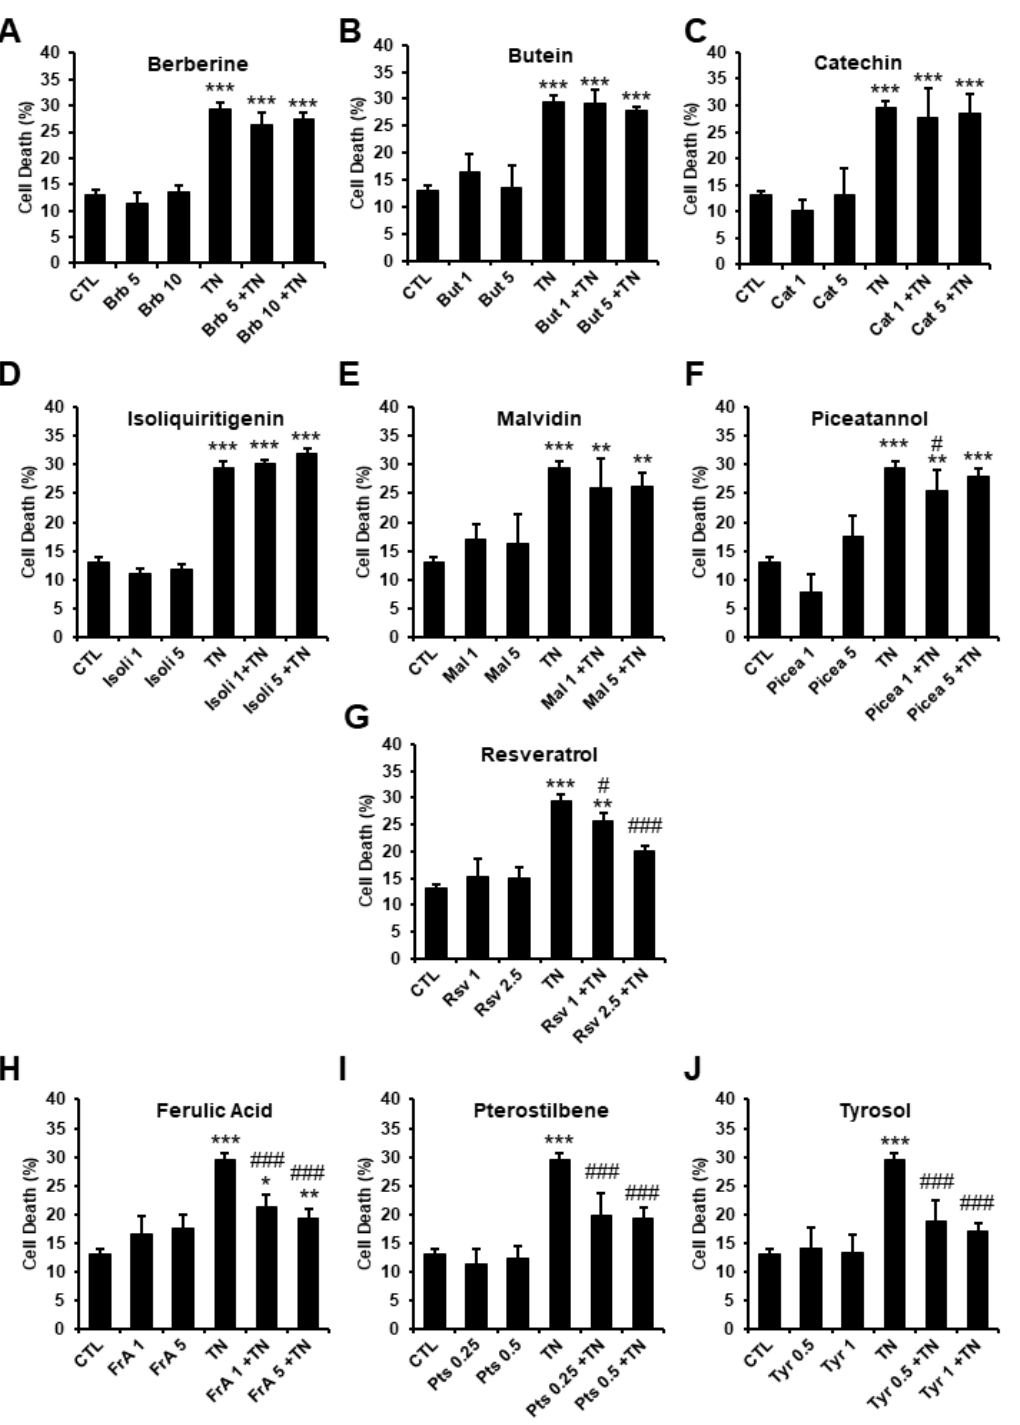
Figure 3. Effect of phenolic compounds on ER-stress-induced cardiomyocyte cell death. Cell death was evaluated by fluorescence microscopy using FDA assay. The FDA is cleaved into green fluorescein by intracellular esterases present in living cells. All non-FDA-fluorescing cells are considered dead. The percentages of dead cells are presented (Cell death (%)). Adult rat ventricular myocytes (ARVM) were treated for 24 h with tunicamycin (TN, 10 µ g/mL) after 1 h pre-treatment with berberine ( A , n = 3), butein ( B , n = 3), catechin ( C , n = 5), isoliquiritigenin ( D , n = 3), malvidin ( E , n = 4), piceatannol ( F , n = 4), resveratrol ( G , n = 3), ferulic acid ( H , n = 6), pterostilbene ( I , n = 5), or tyrosol ( J , n = 5). Concentrations used are expressed in µ M. Values represent mean ± S.E.M. * p < 0.05, ** p < 0.01, *** p < 0.001 vs. control; # p < 0.05, ### p < 0.001 vs.